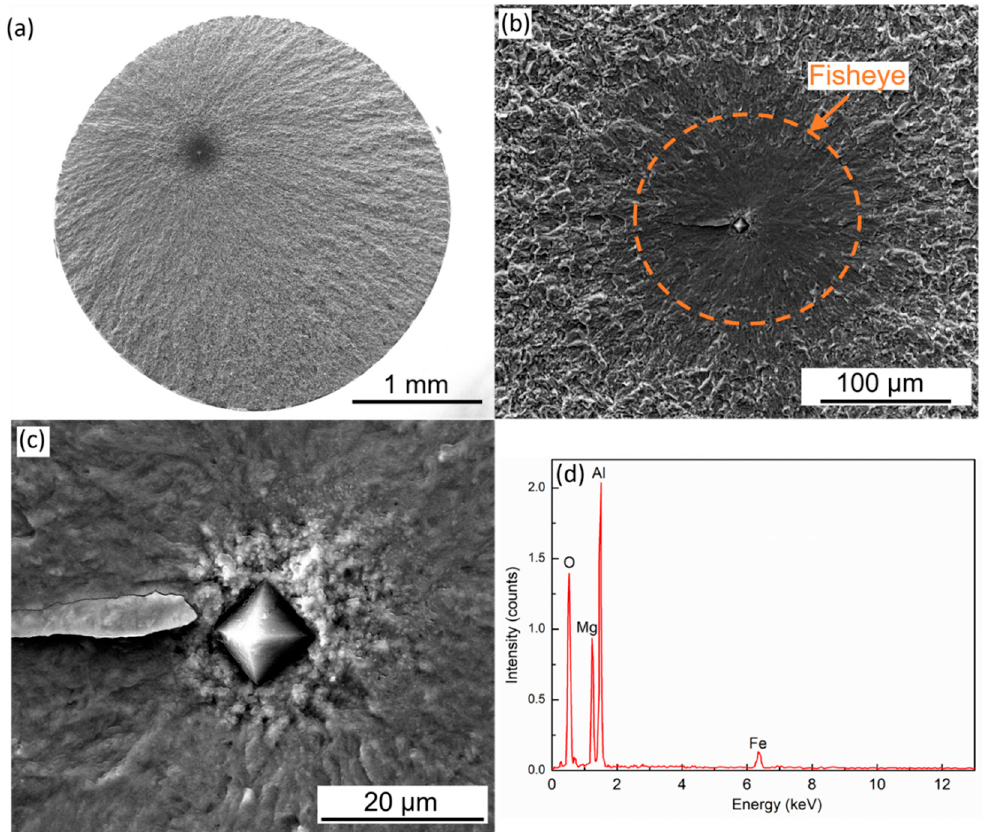
Figure 6. Typical morphologies of the fatigue crack initiated from a spinel inclusion: ( a ) Fracture surface; ( b ) fish eye structure; ( c ) inclusion in the crack initiation site; ( d ) EDS analysis of the inclusion.